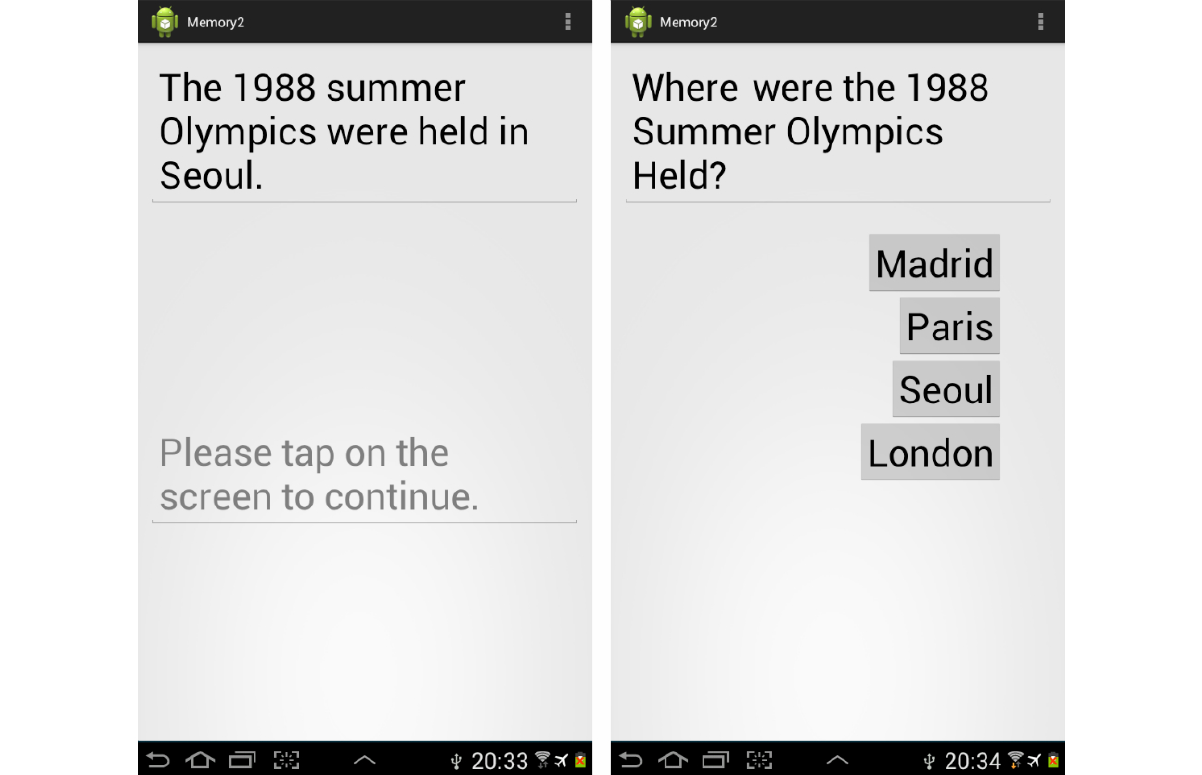
Figure 2. Screenshots of the text-based spaced retrieval